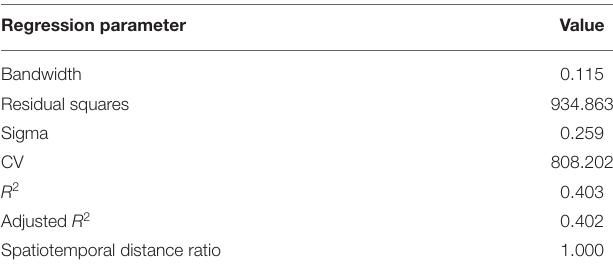
TABLE 2 | Regression parameters of the GTWR